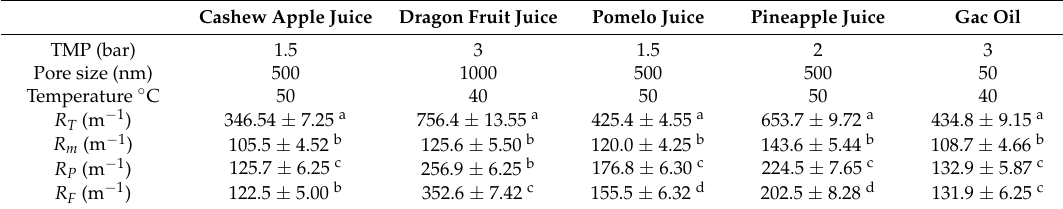
Table 8. Resistance during filtration